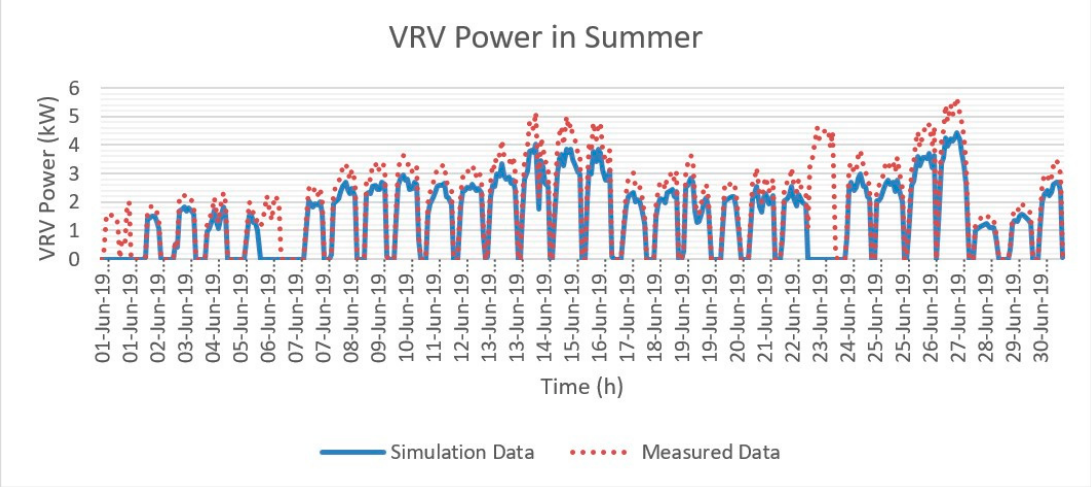
Figure 8. The measured and simulated power consumption in winter. Figures 7 and 8 show that the monitored VRV power in summer was higher than the simulated results. This could be due to the high monitored ambient temperatures during June. The results of the VRV power in winter showed values between the measured and simulated results. Figures 9 and 10 show the sensible effectiveness values ( ɛ s ) of the heat wheel as a function of fresh air inlet temperature in winter (heating) and summer (cooling), respectively.